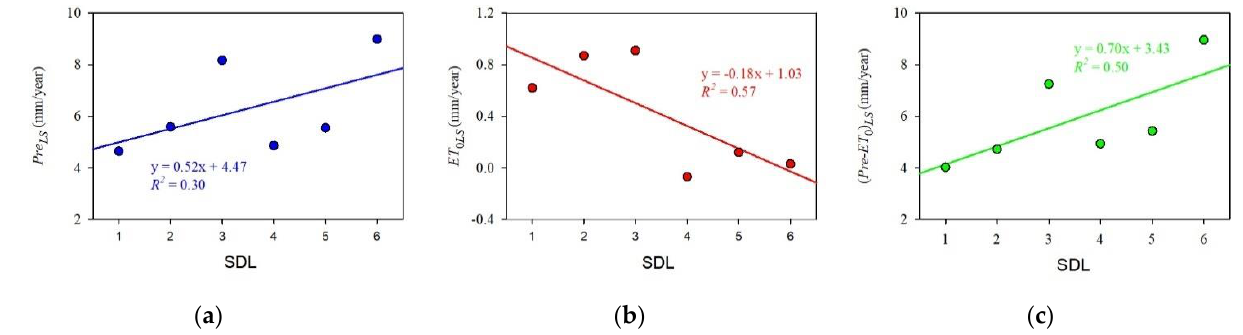
Figure 10. Relationship between SDLs, and average P LS , ET 0 LS , and ( Pre-ET 0 ) LS . ( a ) Pre LS vs. SDL. ( b ) ET 0 LS vs. SDL. ( c ) ( Pre-ET 0 ) LS vs. SDL. ( b ) ET 0 LS vs. SDL. ( c ) ( Pre-ET 0 ) LS vs.